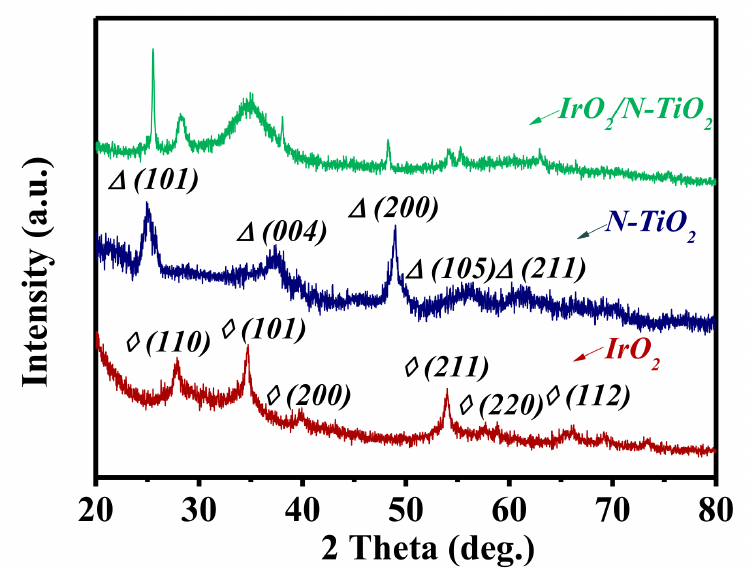
Figure 1. XRD patterns of the prepared samples.